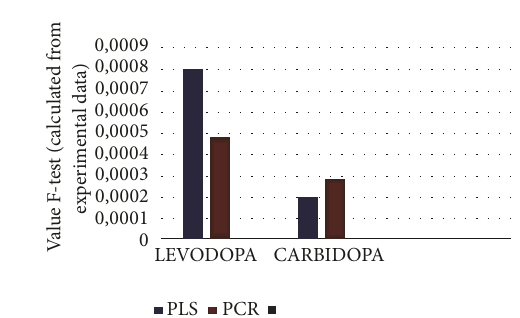
Figure 4: The results of the one-way ANOVA test according to Snedecor’s F